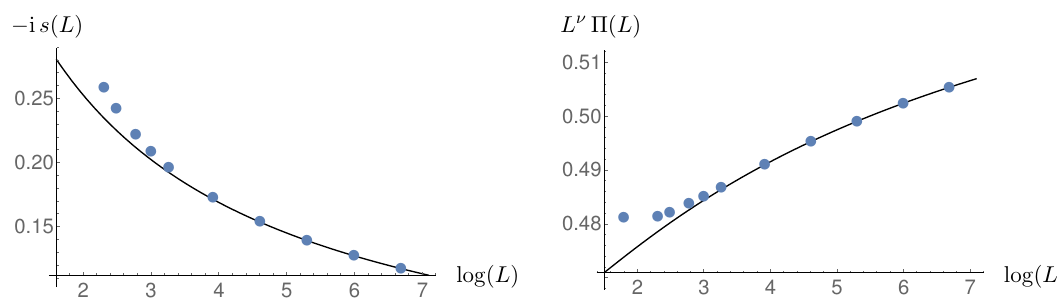
Figure 12. The scale dependence of s ( L ) (left panel) and L (cid:23) (cid:5)( L ) with (cid:23) = 2 n ( p (cid:0) (cid:22) p )